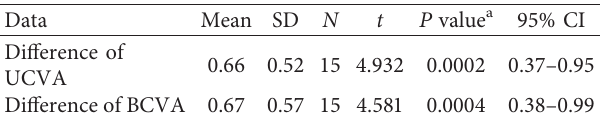
Table 2: The difference in visual acuity (log MAR) before and after surgery. Data Mean SD N Difference